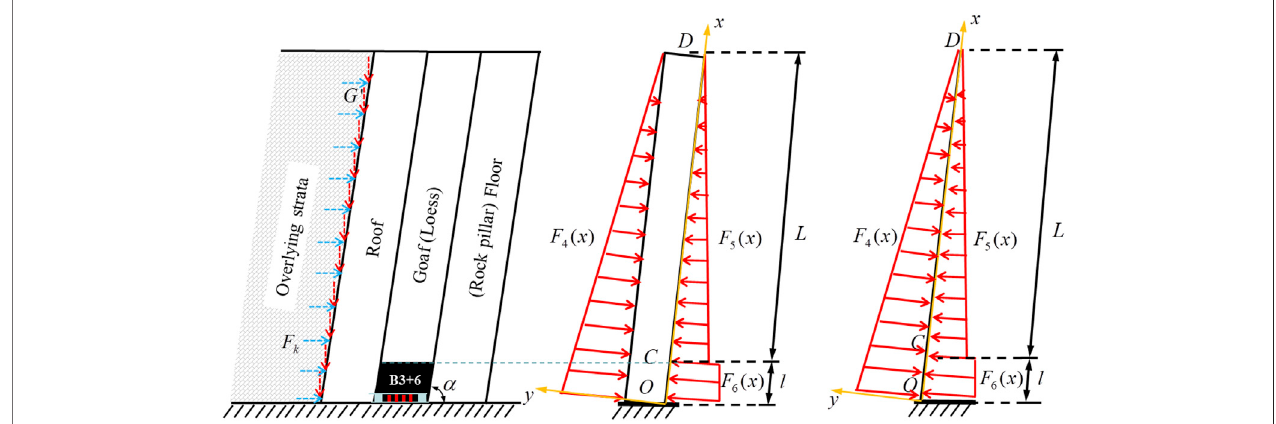
FIGURE 6 | Mechanical model of a rock pillar.